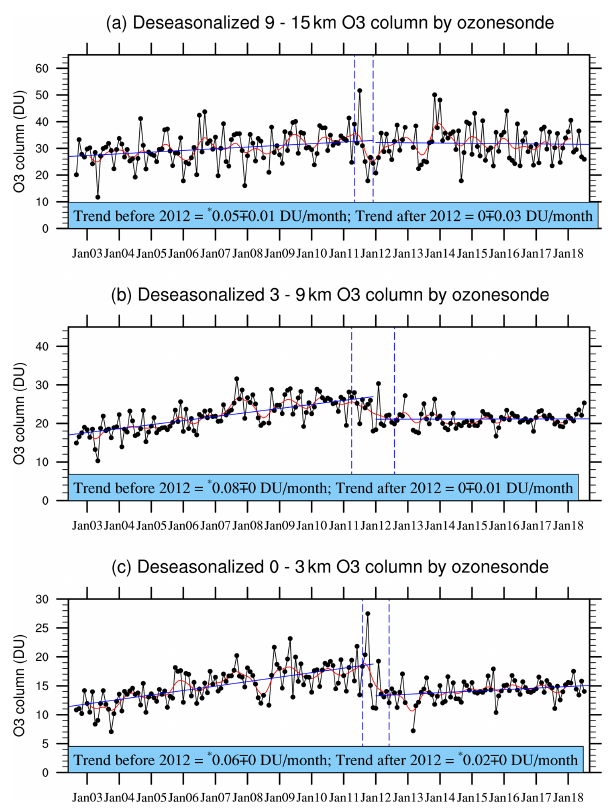
Figure 3. Deseasonalized monthly mean partial columns of ozone over Beijing (solid black lines and dots) measured by the IAP ozonesonde and the corresponding Gaussian-weighted means using a half-width of 12 months (red curves). The solid blue lines esti- mate the linear trends (slope ∓ standard error) before and after the decrease in ozone during late 2011 and early 2012. The periods of decrease are represented by the time between the two dashed blue lines. The trends with “*” passed the 95% significance criterion.